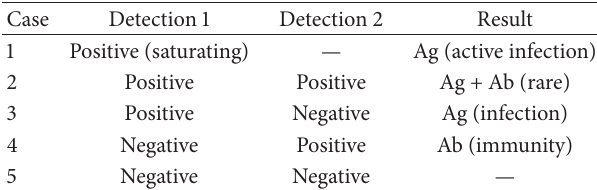
Table 1: Five possibilities in this analytical strategy.